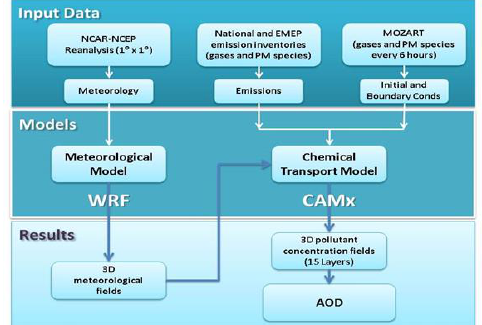
Figure 1. Air quality modelling system – input/output structure